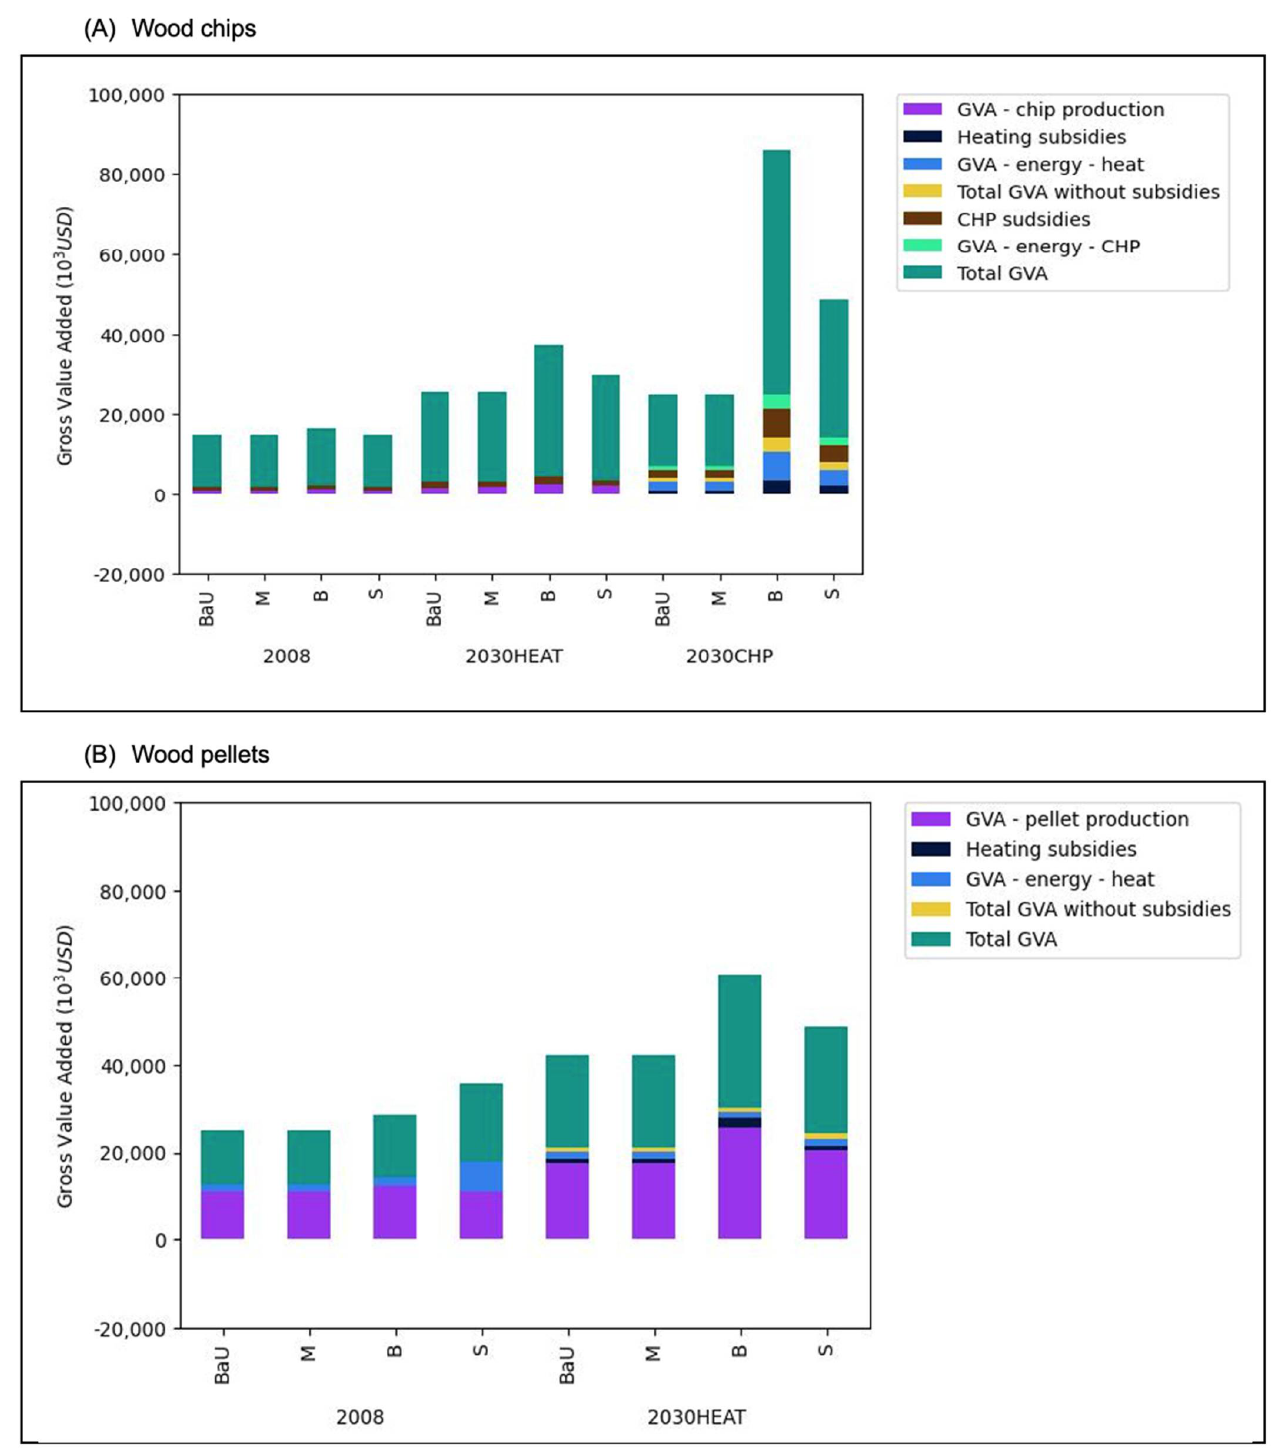
Figure 5. Gross value added for wood chip ( A ) and wood pellet ( B ) value chain scenarios, expressed in US dollars